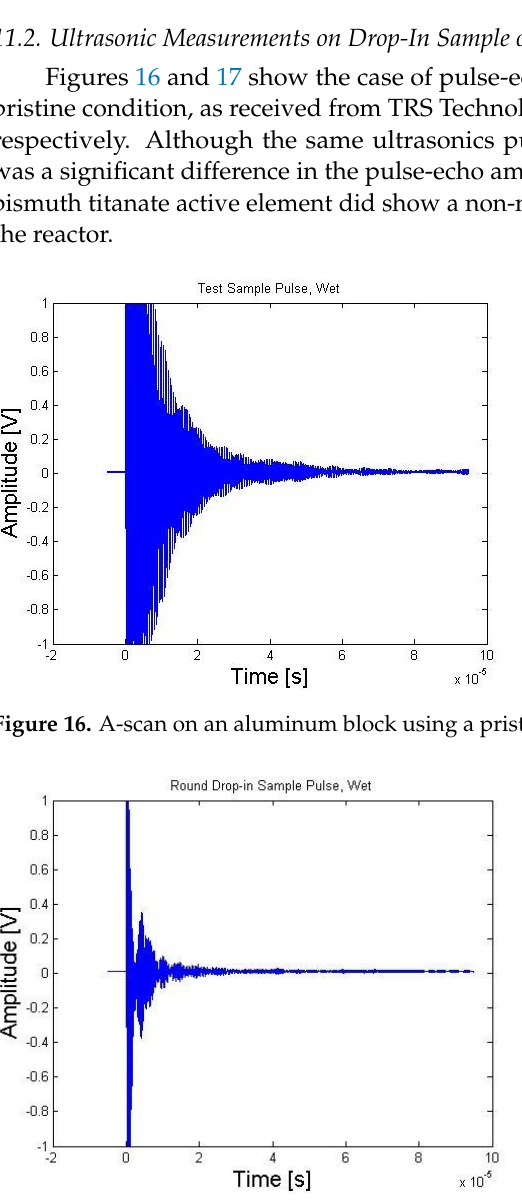
Figure 15. Bismuth titanate (BiTi) drop-in wafers. To the left in ( a ) is the pre-irradiated image and to the right in ( b ) is the post-irradiated bismuth titanate (BiTi) sample [14].